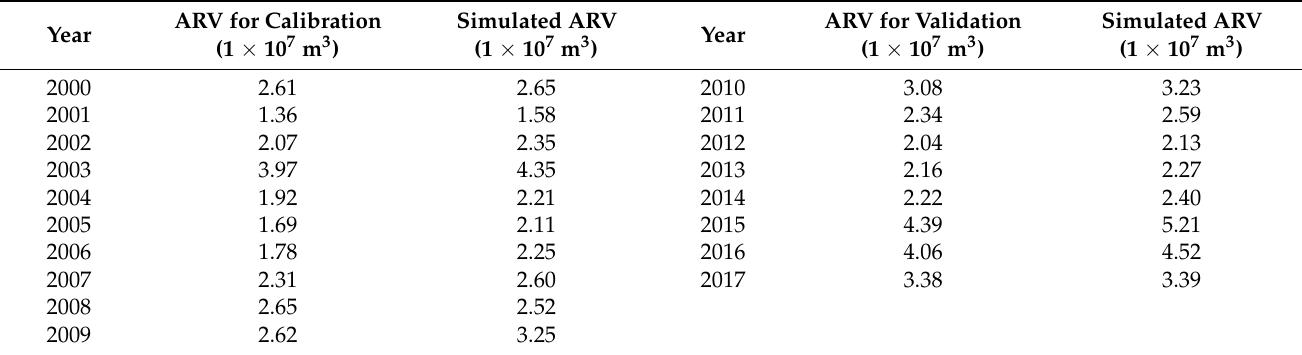
Table 4. Surface runoff volume for the scenario without any GI practices implemented (S0).